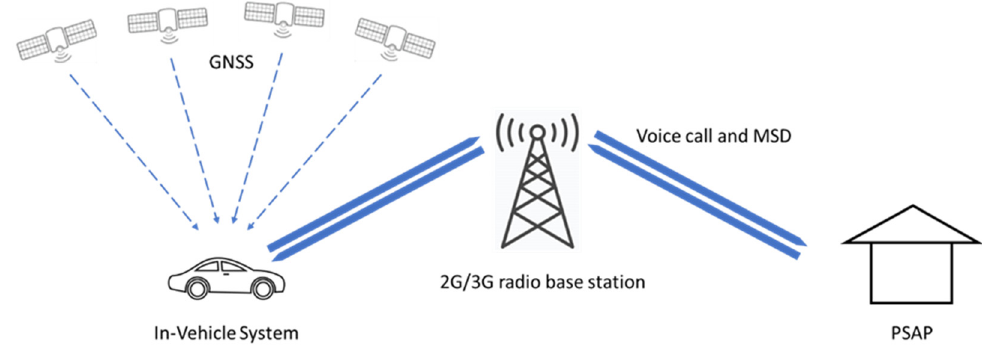
Figure 1. Pan-European eCall system.